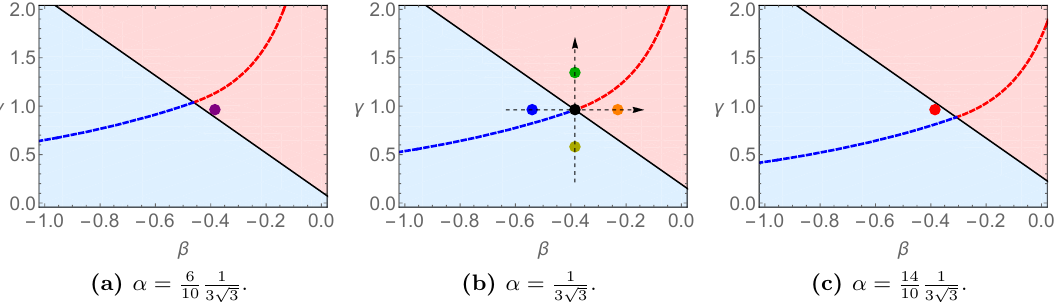
Figure 9. Allowed ( (cid:12); (cid:13) ) region for a given (cid:11) > 0. In (cid:12)gure 10 we show the resistivity for the parameters corresponding to the dots in (a), (b), and (c). See the items 1-5 in sec, 5.2 for the meanings of colors, lines, and dots.